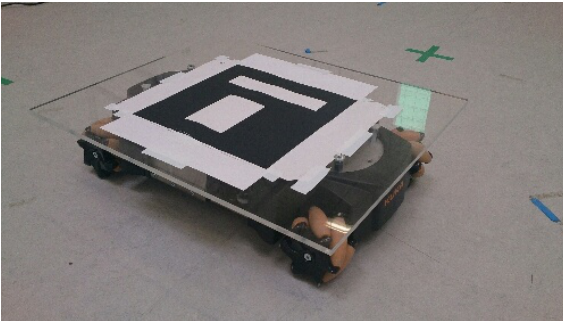
Figure 17. Youbot platform with the ArUco target.